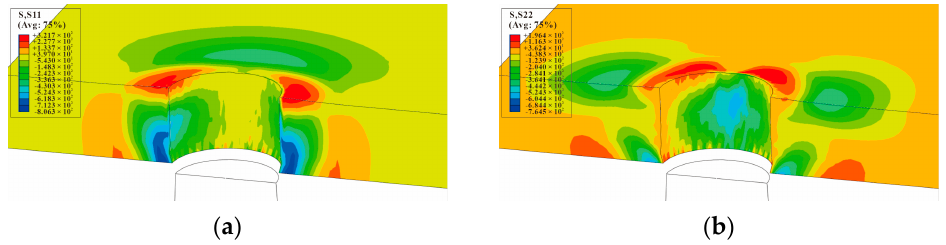
Figure 15. The nephogram of circumferential and radial residual stress around the hole of single- hole SSCE when the mandrel extrudes the middle hole: ( a ) S11/circumferential stress distribution nephogram (MPa); ( b ) S22/radial stress distribution nephogram (MPa).